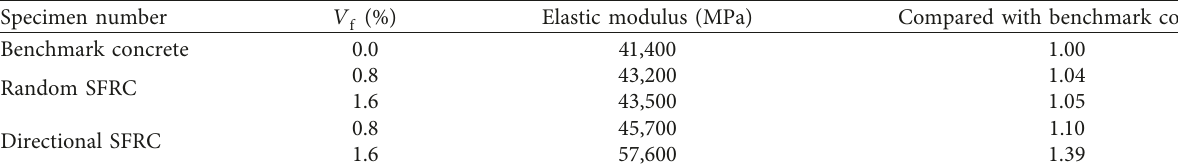
Table 4: Elastic modulus of concrete.